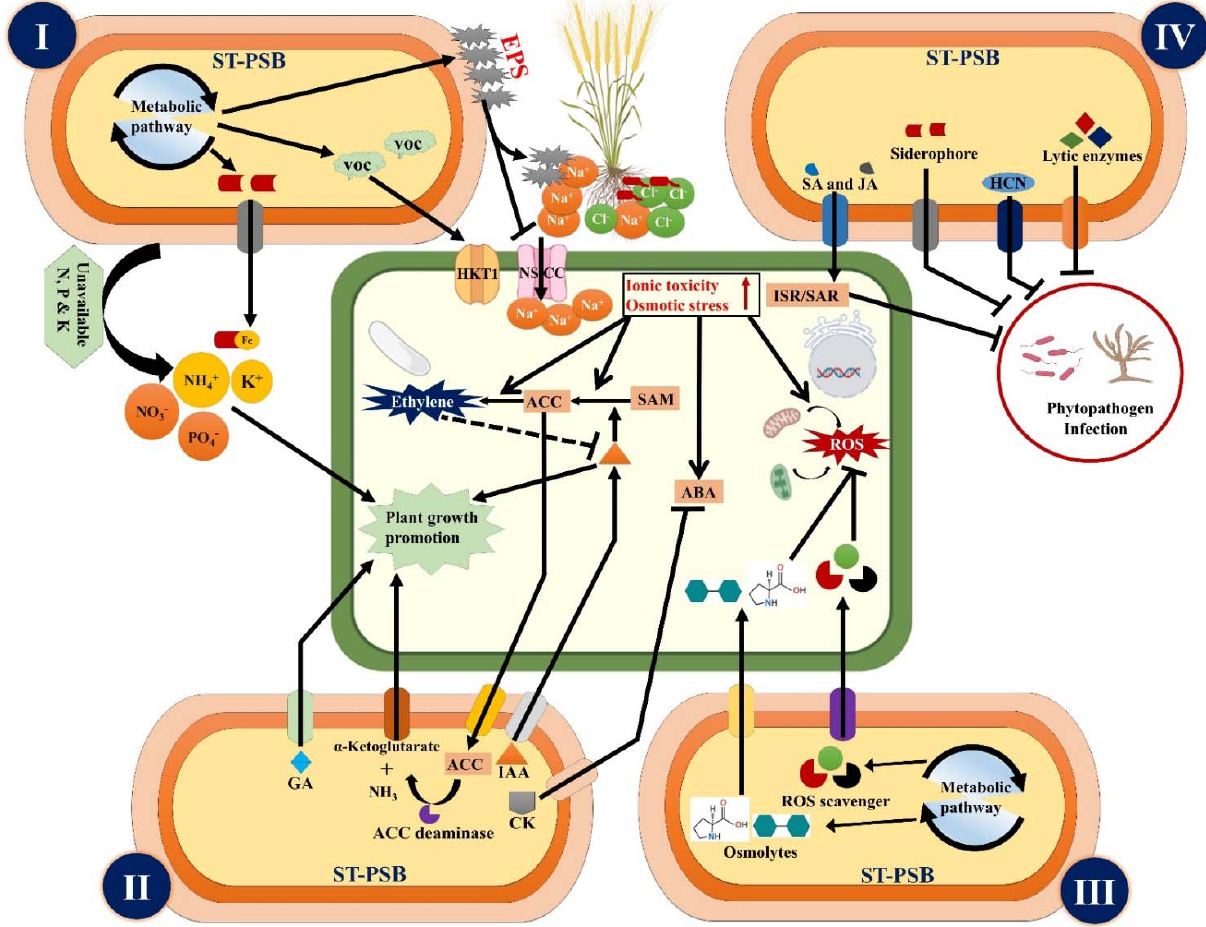
Figure 3. A schematic overview of the salt tolerance mechanism in plant cells through the salt-tolerant phosphate solubilizing Figure 3. An overview of salt tolerance mechanisms in plant root cells, as well as the role of halotolerant bacteria in salt bacteria: ( I ) Ionic homeostasis and nutritional balance in plant (e.g., production of EPS bind with Na + and decreasing Na tolerance; Ionic (Na + ) and osmotic signals are used by plants to detect salt stress. The weakly voltage–dependent nonse ‐ lective cation channels (NSCCs) and the high–affinity K + (HKT) transport sodium through the plasma membrane, allowing salt (Na + ) to enter the root. Although both of these channels can control Na + and K + influx into plant cells and some chan ‐ nels are more selective for K + than others. HKT1, which is a critical predictor of plant salinity tolerance in response to salt stress, can improve salt tolerance by decreasing Na + build up in shoot tissue, which protects leaves from Na + toxicity. Salt tolerant phosphate solubilizing bacteria can also help enhance the tolerance of the plant to salinity by ( a ) ion homeostasis in the plant (e.g., by increasing K + ion uptake via mediating the expression of an ion high–affinity K + transporter (HKT1) and VOC in plant); ( b ) production of exopolysaccharides (e.g., through increasing water intake and soil water holding capacity and decreasing Na + uptake by plants); ( c ) Enhance uptake of N, P and K to solubilize P and fix nitrogen to main ‐ tain nutritional balance; ( d ) induction of synthesizing plant antioxidative enzymes (POD, SOD, CAT, APX & GR) to scav ‐ enge ROS; ( e ) increasing osmolyte accumulation (Proline, glycine betaine, soluble sugar and choline) to maintain osmotic balance in plants; and ( f ) regulation of phytohormonal content (e.g., ethylene, abscisic acid, auxin etc.) to enhance salt stress tolerance and plant growth; ( g ) production of HCN, siderophores, salicylic acid, jasmonic acid and lytic enzymes to control phytopathogen infections. As mentioned above, salinity moderates the uptake/accumulation of plant nutrients including N, P, and K, which directly affect plant growth. In addition to phosphate solu ‐